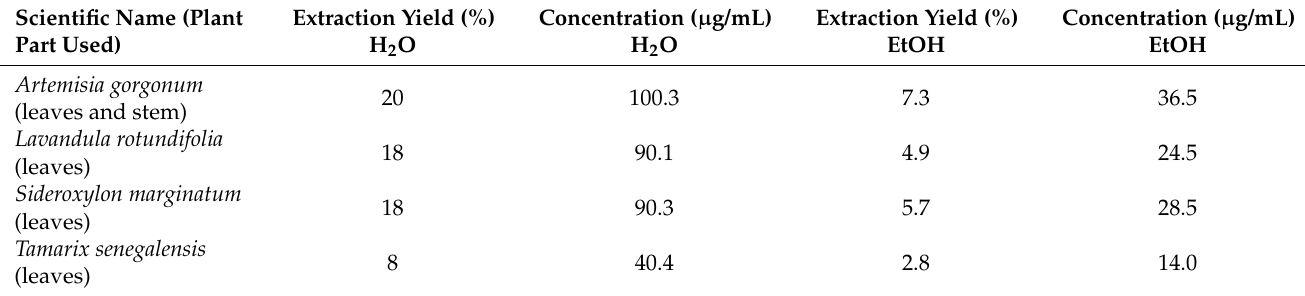
Table 1. Percentage yield and concentration of infusions from the prepared ethanolic plant extracts.